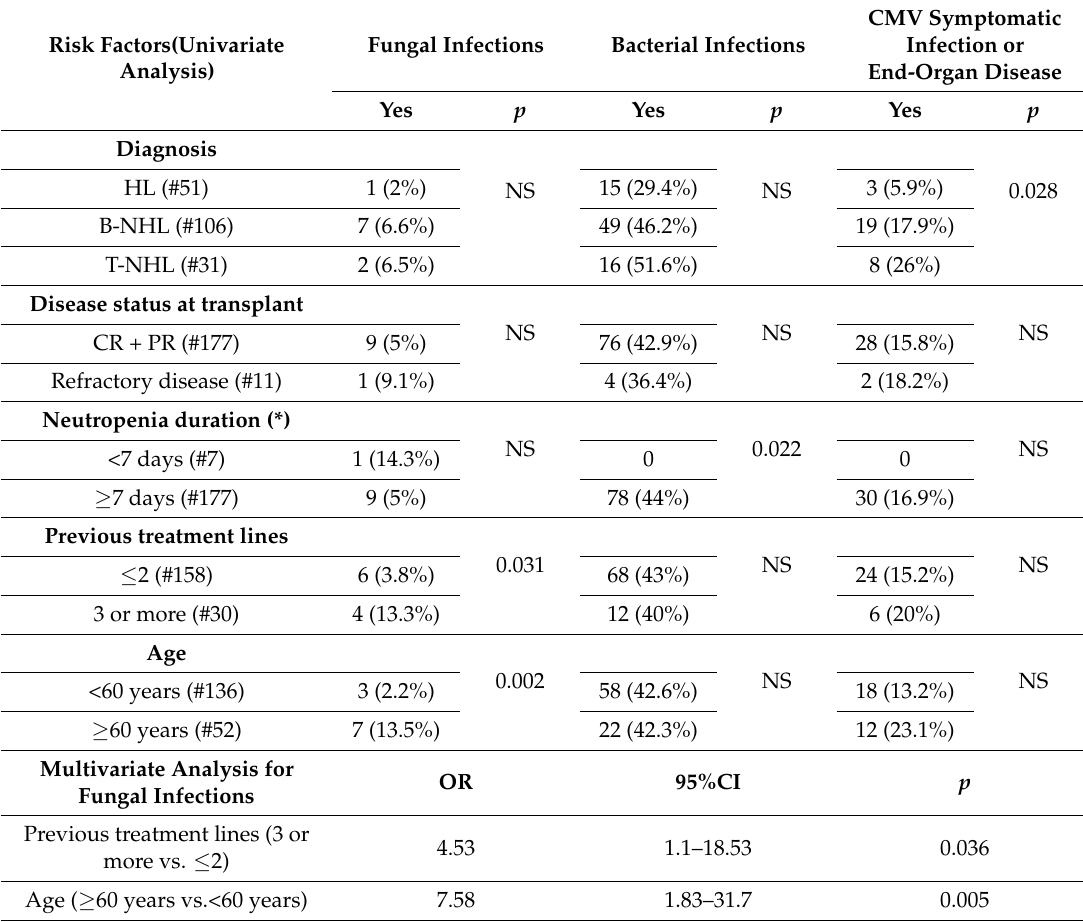
Table 6. Risk factors for CMV, fungal and bacterial infection in our study cohort of 188 ASCTs performed in lymphoma